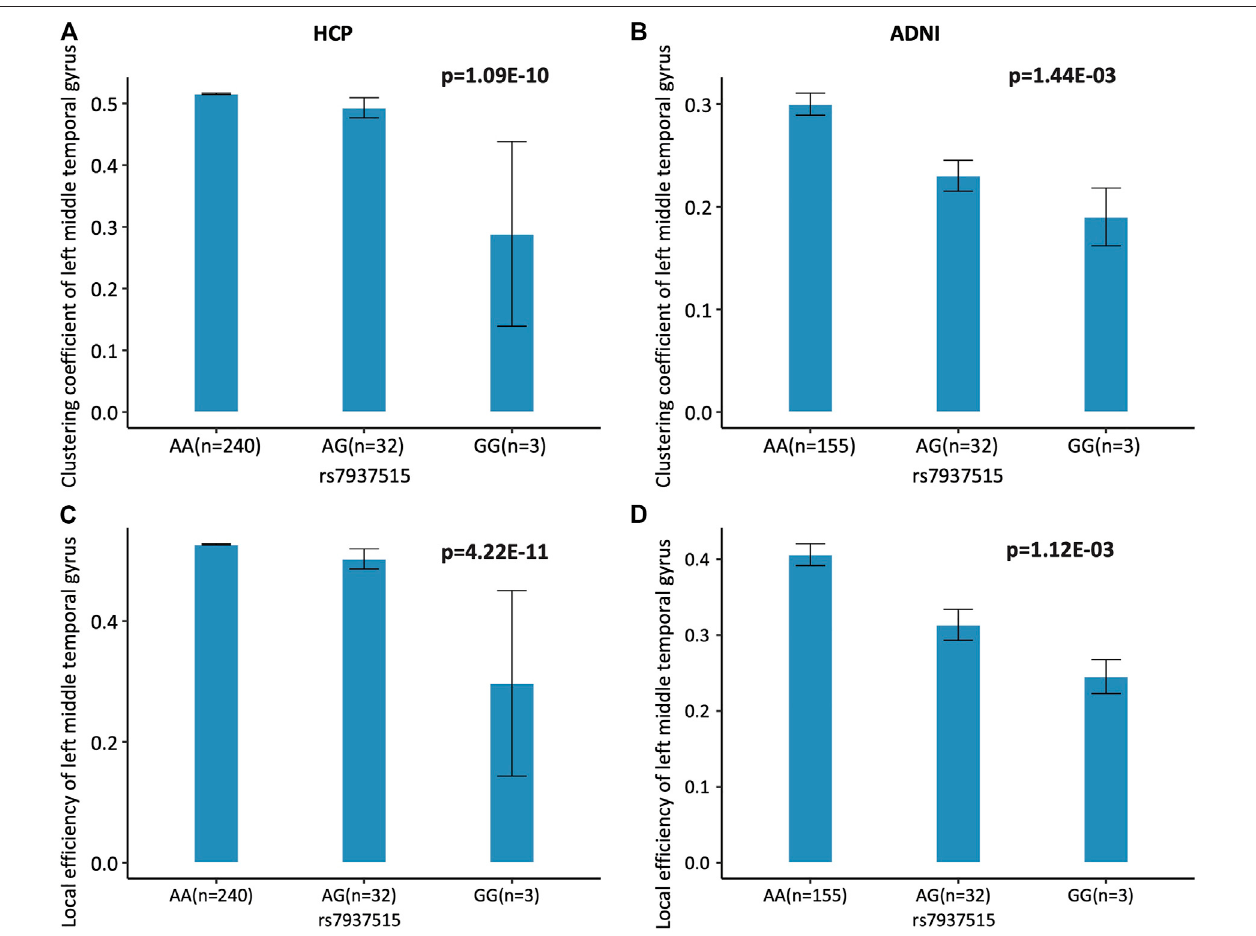
FIGURE3| Associationofrs7937515onclusteringcoef fi cientandlocalef fi ciencyoftheleftmiddletemporalgyrus. (A,B) Meanclusteringcoef fi cientwithstandard errors are plotted against the rs7937515 genotype groups (i.e., AA, AG and GG) for the HCP and ADNI cohorts, respectively. (C,D) Mean local ef fi ciency with standard errors are plotted against the rs7937515 genotype groups (i.e., AA, AG and GG) for the HCP and ADNI cohorts, respectively. p values are calculated from GWAS (HCP) and targeted analysis (ADNI), and signi fi cant p values are marked in bold.